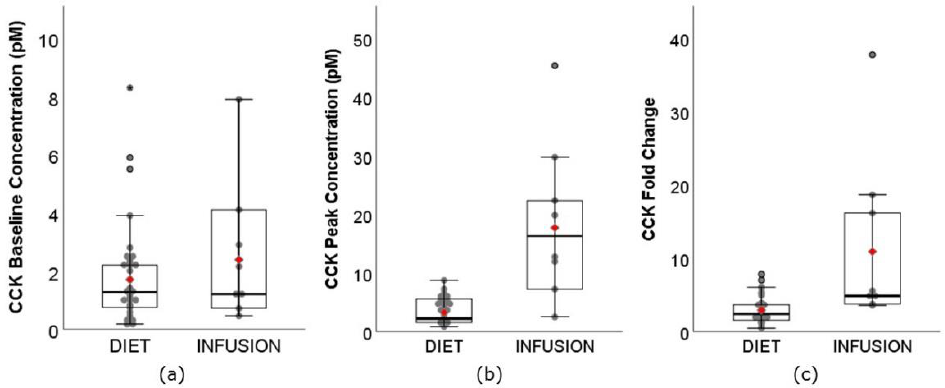
Figure 3. Boxplots showing the ( a ) baseline concentration, ( b ) C max , peak concentration, and ( c ) fold change of CCK between DIET (N = 620, K = 39) and INFUSION (N = 98, K = 8). The weighted means were significantly different between DIET and INFUSION for all ( p < 0.01, all).